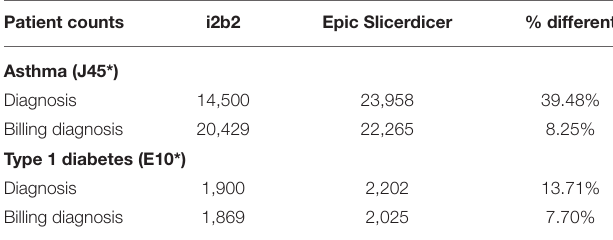
TABLE 2 | Patients demographic counts. TABLE 3 | Patients count based on diagnosis